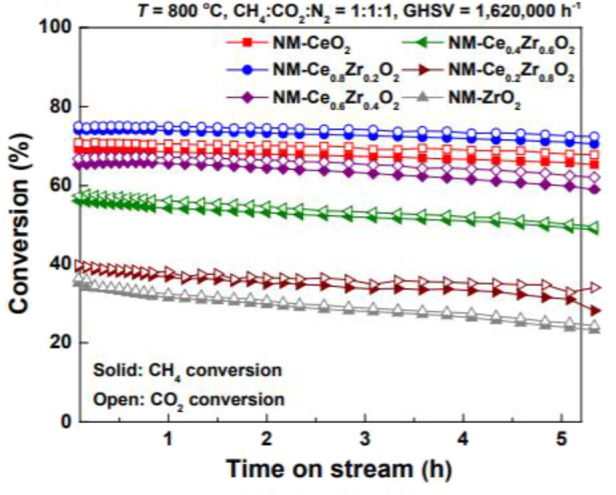
CH4 and CO2 conversions with time on stream (TOS) over NMCeO2, NM-ZrO2, and NM-Ce(1−x)Zr(x)O2 catalysts in CRM reaction (T = 800°C, CH4:CO2:N2 = 1:1:1, and GHSV = 1,620,000 mL·g−1·h−1). Reproduced from Jang et al. (2018) with permission from Green Chemistry.